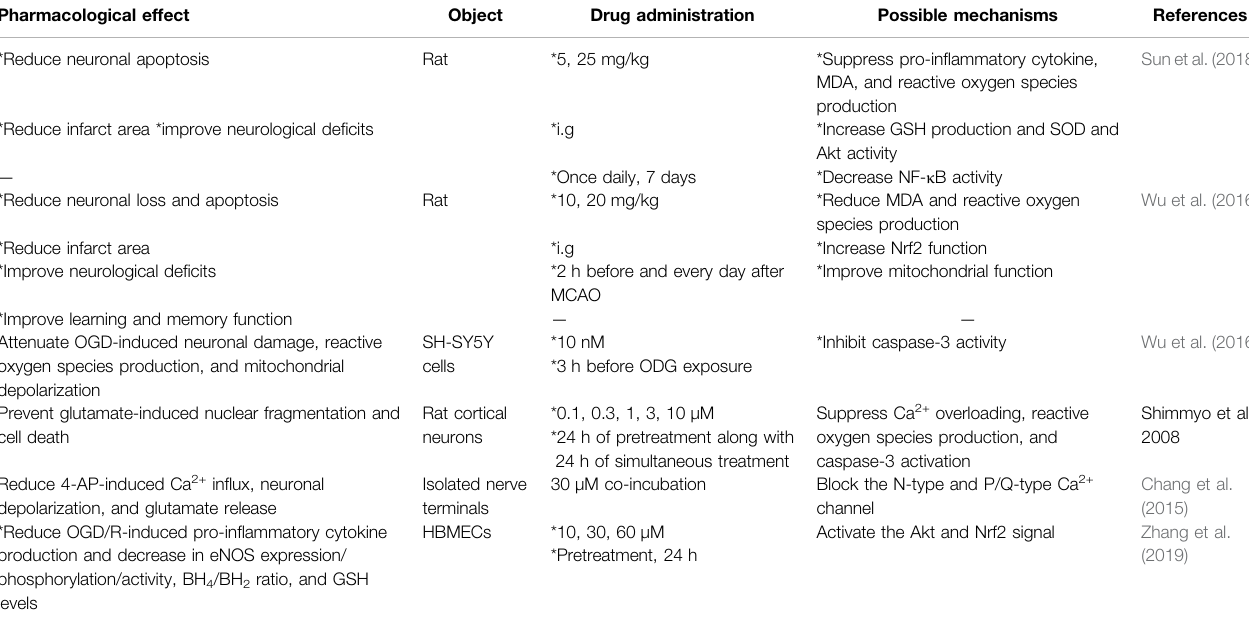
TABLE 1 | Comprehensive information about the effects of myricetin in in vivo and in vitro models cerebral